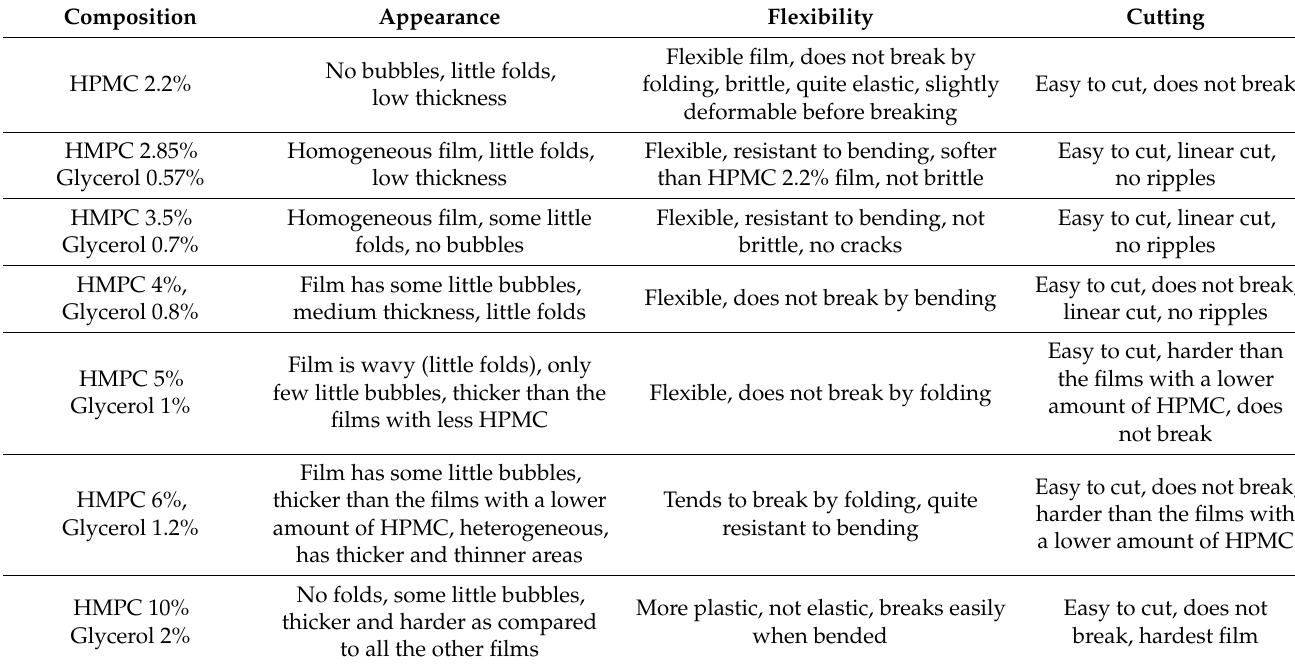
Table 2. Appearance, flexibility, and cutting properties of blank films. HPMC and glycerol concentrations are expressed in % ( w / v ), and their ratio was kept constant (5:1) throughout the tests.